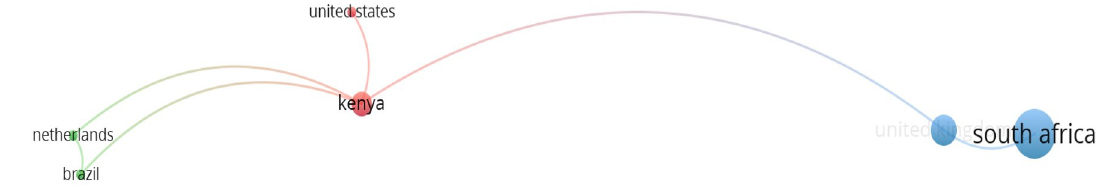
Fig 4. Visualization of co-authorships by country.